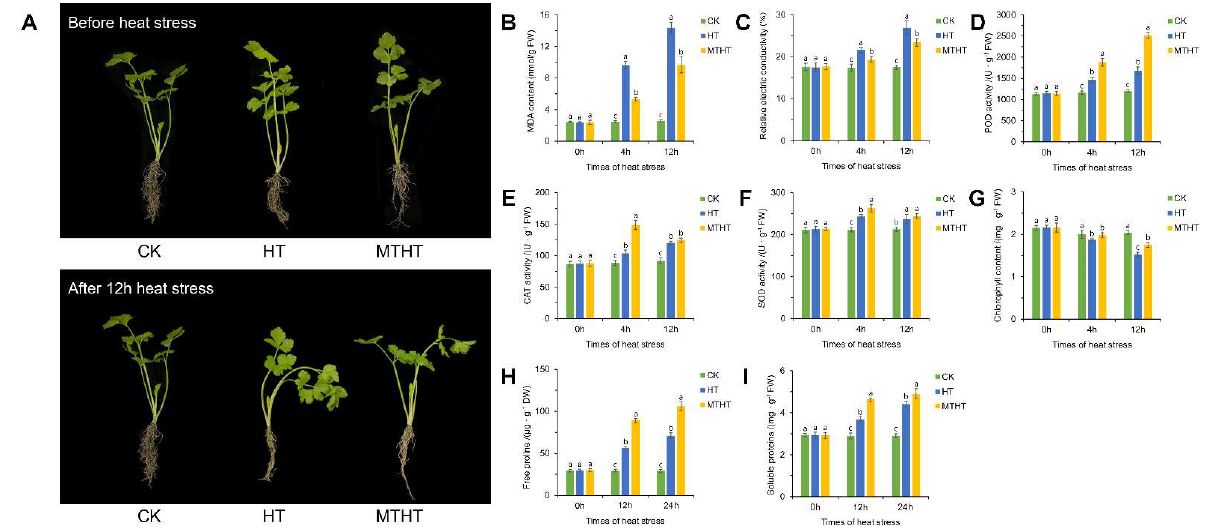
Figure 1. Effects of heat stress on celery. ( A ) Phenotypic characteristics of celery seedlings under heat stress. ( B – I ) Effects of heat stress on physiological characteristics of celery. ( B ) Malondialdehyde (MDA), ( C ) relative conductivity, ( D ) peroxidase (POD), ( E ) catalase (CAT), ( F ) superoxide dismutase (SOD), ( G ) chlorophyll content, ( H ) free proline content, and ( I ) soluble protein. Each error line represents the mean ± SD, t -test with significance level of 0.05 ( p < 0.05). The different letters (a–c) indicate a significant difference, and the same letter indicates no significant difference. CK: non-treatment group, HT: water-sprayed group, MTHT: 100 µ mol · L − 1 MT-sprayed